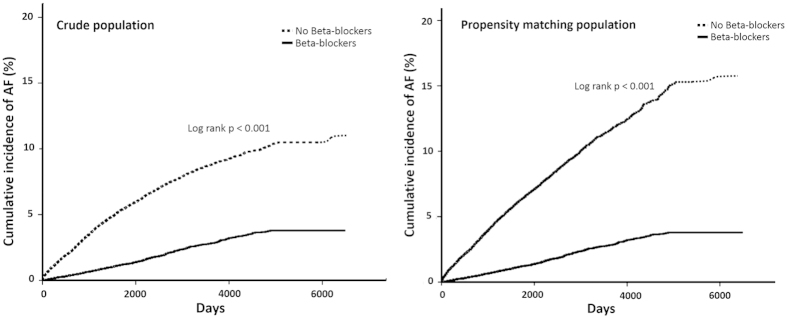
Kaplan–Meier curves showing the development of atrial fibrillation according to beta-blocker treatment.